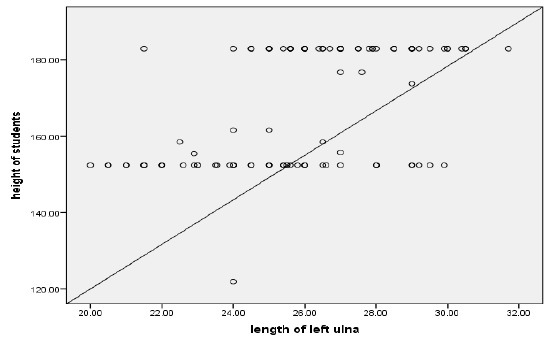
Fig. 1: Correlation of Height with length of left ulna in both sexes together.